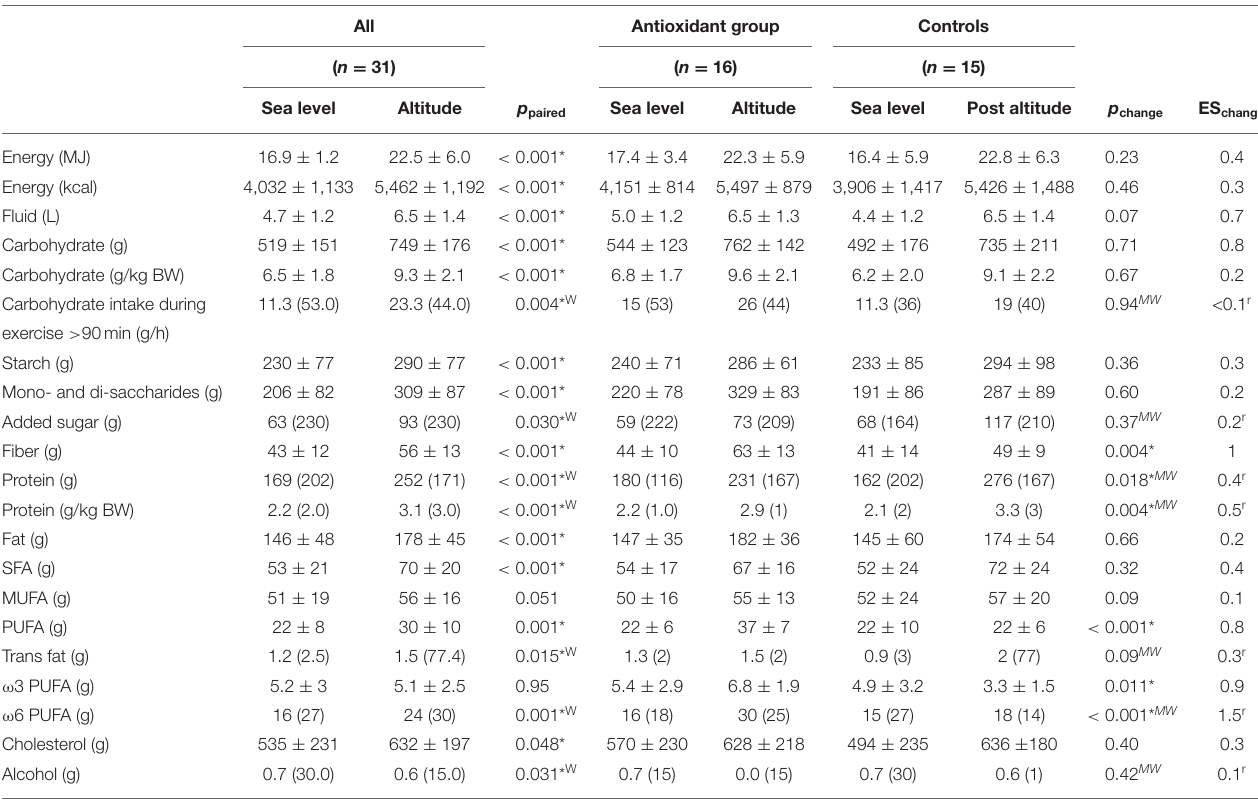
TABLE 3 | Mean daily energy, fluid, and macronutrient intake before (Sea level) and during (Altitude) the 3-week training camp at